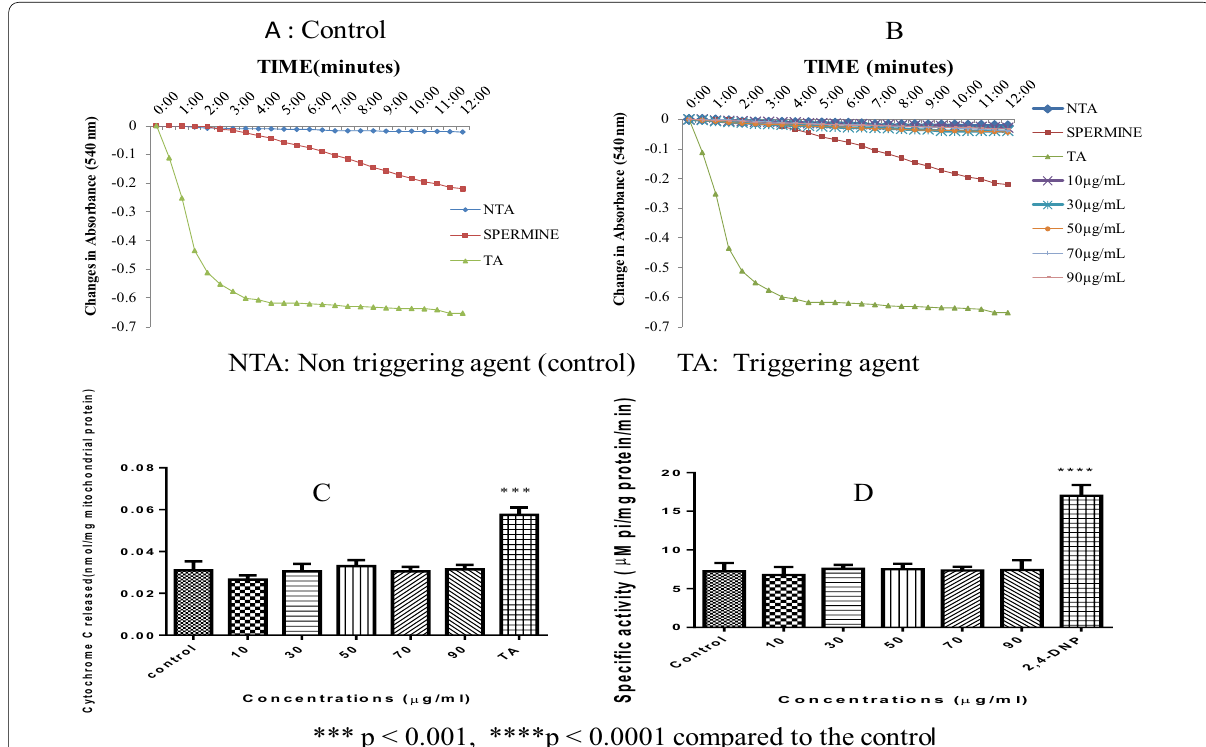
Fig. 1 Mitochondrial intactness ( a ) and effects of varying concentrations of metformin on rat uterus mPT pore opening (representative profile) ( b ), cytochrome c release ( c ) and mitochondrial ATPase activity